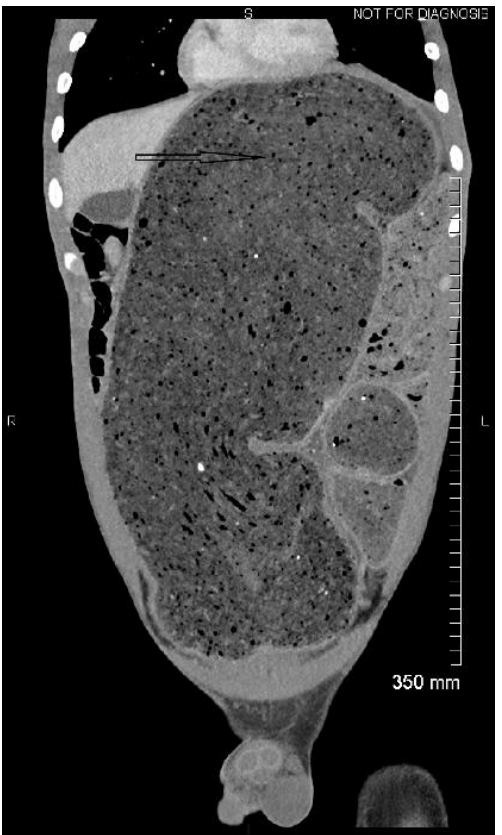
Image 2. Coronal section showing right hydronephrosis (arrow) due to obstructive uropathy from fecal